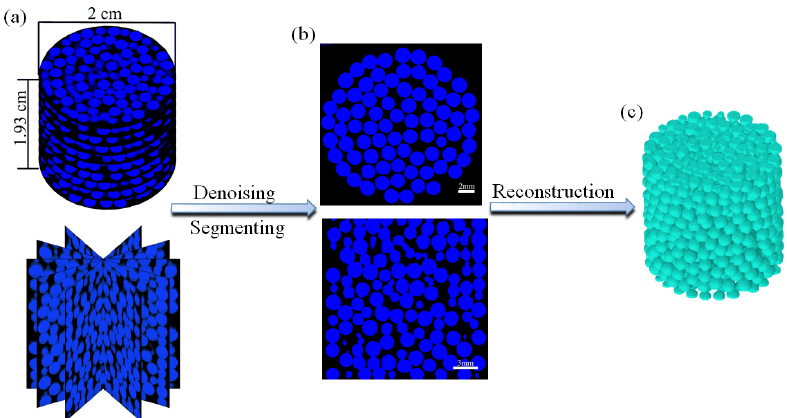
Figure 5. Reconstruction of stacking model: ( a ) scanned images; ( b ) images obtained after filtering, denoising and segmenting; ( c ) 3D model of reconstruction.